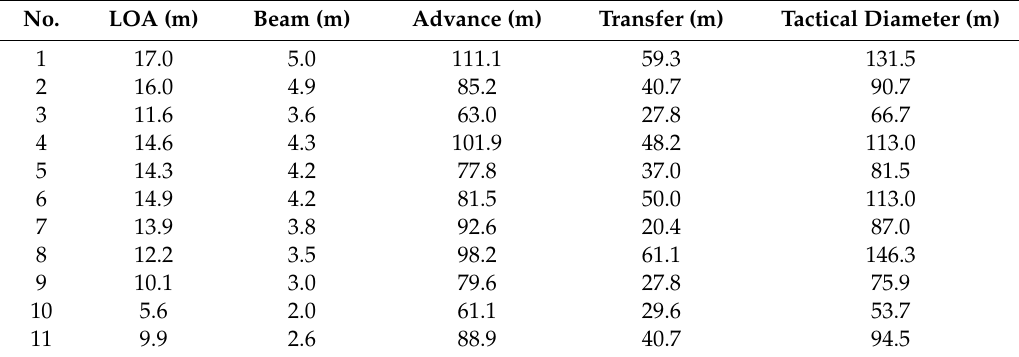
Table 2. Maneuvering data for small vessels (LOA = length overall).